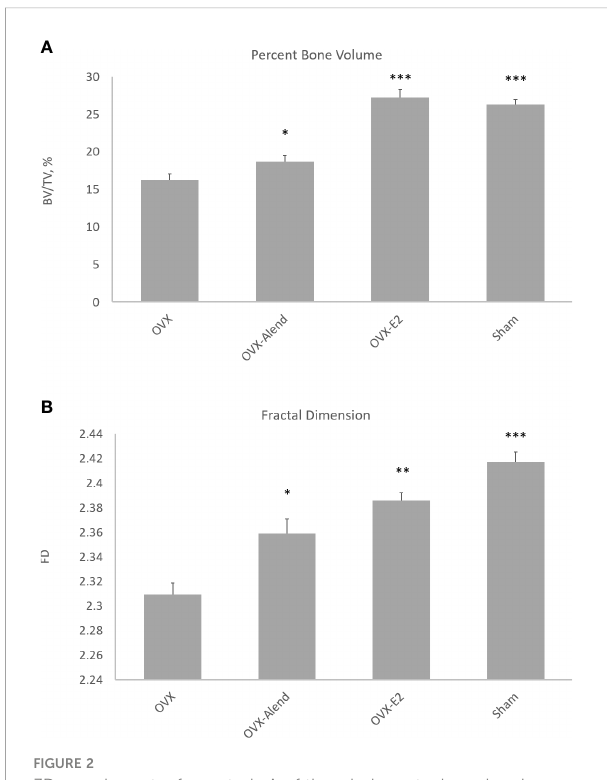
FIGURE 2 3D morphometry from study A of the whole metaphyseal region, with the primary and secondary regions combined. The effect of ovariectomy osteopenia on trabecular mass and architecture and the amelioration of this effect by alendronate and estradiol (E2) treatment are shown for the parameters percent trabecular volume (A) and fractal dimension (B) . * p < 0.05, ** p < 0.01, *** p <